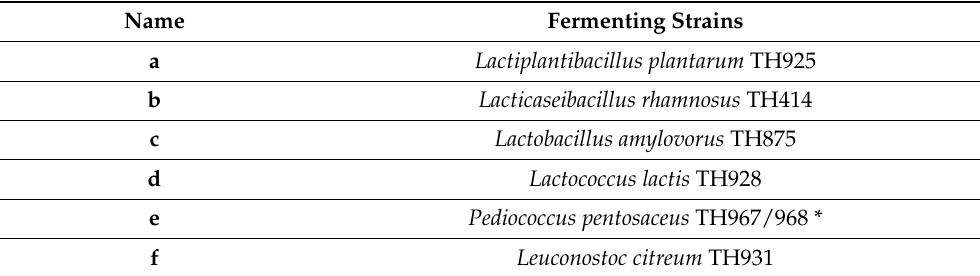
Table 1. Lactic acid bacteria strains used in the fermentation tests.